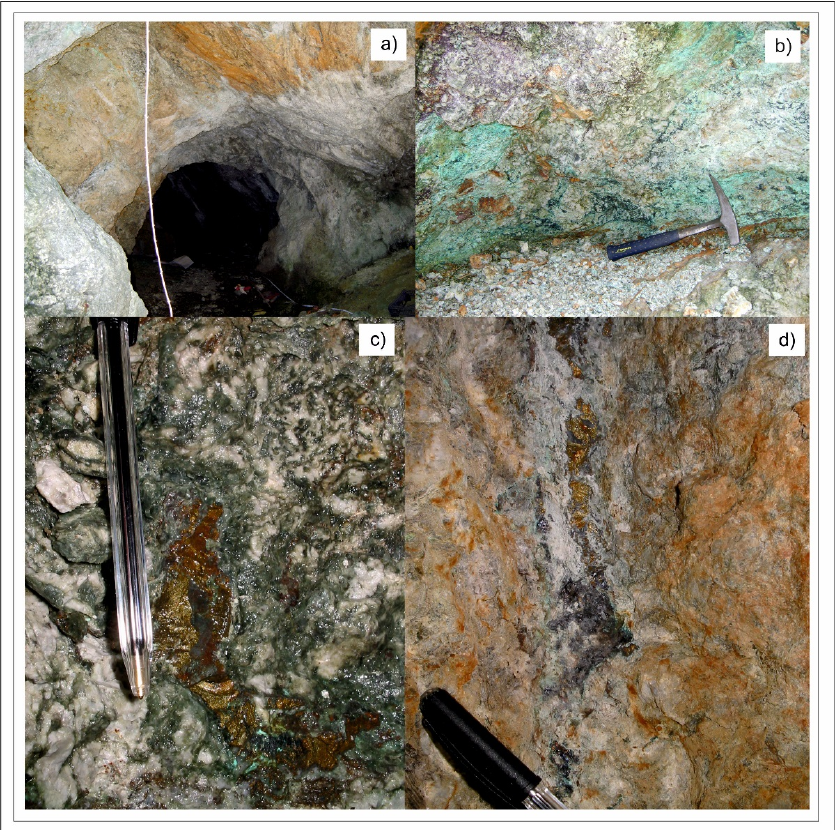
Figure 12. Macroscopic features of the mineralization at the Piazza mine. ( a ) Zone of hydrothermally altered, mineralized gabbro intersected by a tunnel. ( b ) Exposure of mineralized gabbro with secondary Cu minerals marking the development of the Cu-rich stockwork. ( c ) Fresh fracture of chloritized gabbro hosting irregular enrichment of Cu sulfides (chalcopyrite in orange and bornite in blue) along a thin hydrothermal veinlet. ( d ) Bornite-rich sulfide patch in whitish prehnite along veinlets in altered gabbro (the rusty color is due to surficial coatings along the mine tunnel). Ore minerals occur as irregular aggregates and disseminated blebs within the brecciated host gabbro (Figure 13a), filling fractures and open cavities together with gangue minerals represented by prehnite, albite, minor chlorite, and extremely rare quartz. The ore is dominated by copper sulfides, bornite and chalcopyrite (the former locally altered in secondary Cu sulfides), with abundant